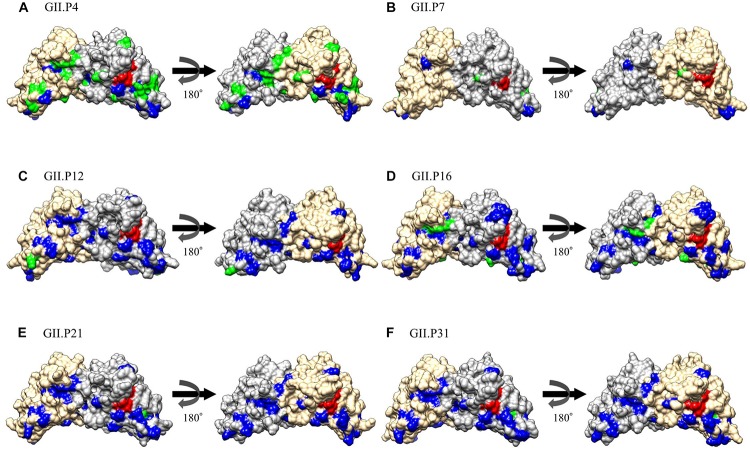
Structural models for the Pro protein of each genotype. Three-dimensional Pro dimer structures for GII.P4 (A), GII.P7 (B), GII.P12 (C), GII.P16 (D), GII.P21 (E), and GII.P31 (F) are shown. The chains composing the dimer structures are colored gray (chain A) and Navajo white (chain B). Negative selection sites are colored green. Amino acid substitutions of the other genotypes compared to a GII.P20 strain are colored blue. Active site residues are colored red.